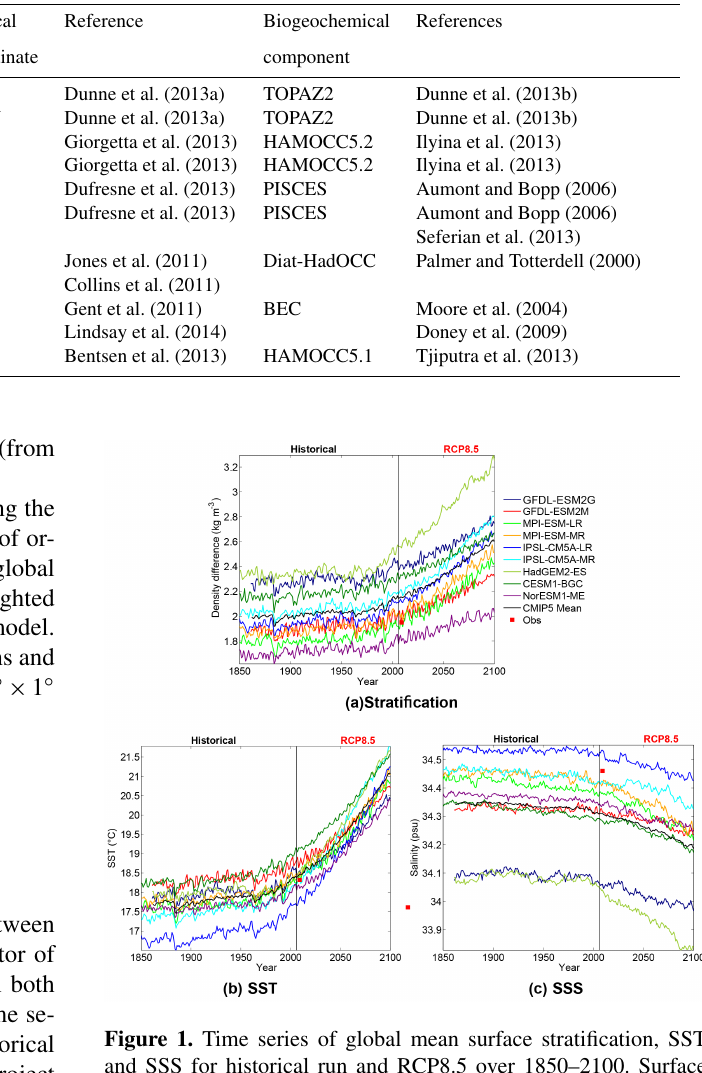
Table 1. A brief description of components of the ESMs used in this study. For atmosphere and ocean components, the number of levels in the vertical is indicated by “lev” and the horizontal resolution is indicated in degrees; vertical coordinates of the ocean and biogeochemical components are indicated by Z (geopotential) or I (isopycnal).